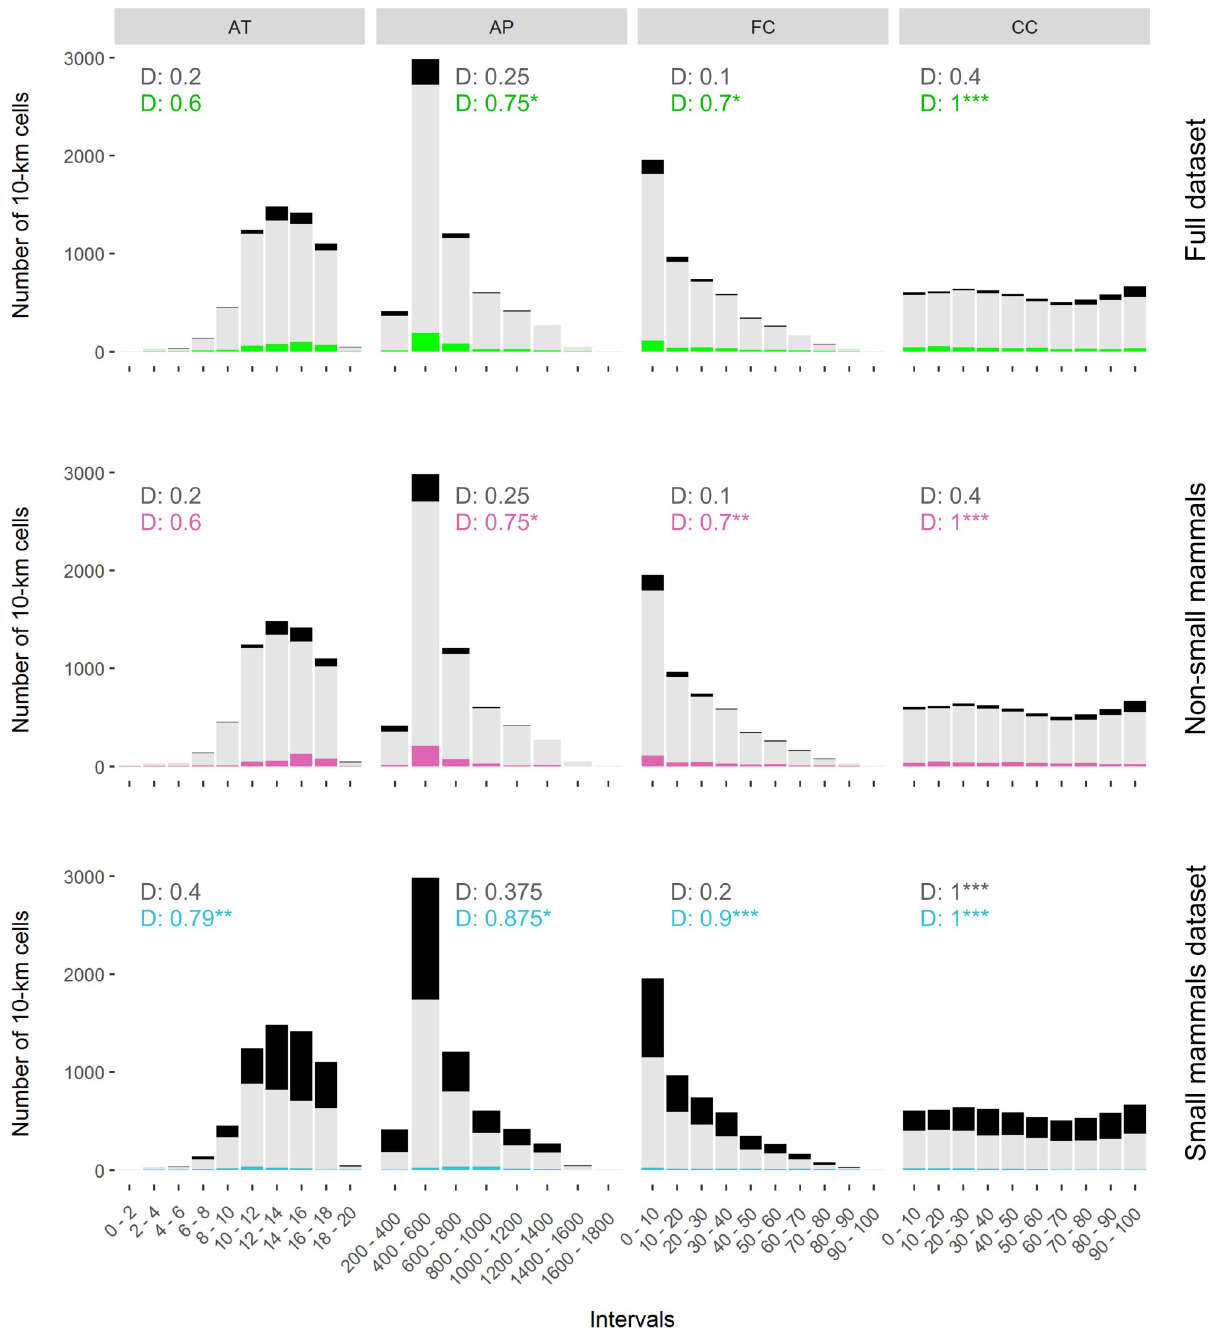
Fig 3. Survey coverage of well-sampled cells (number of records � 25 and Cc � 0.7) along four environmental variables: Annual Mean Temperature (AT), Annual Precipitation (AP), forest coverage (FC), and crops coverage (CC). Green: full dataset; pink: non-small mammals’ dataset (Lagomorpha, Artiodactyla, Carnivora, Chiroptera and Erinaceidae); blue: small mammals’ (Rodentia and Soricidae) dataset; grey: all cells having data (n = 5,874); black: rest of cells in the territory not holding data. Values correspond to the D-statistics from Kolmogorov-Smirnov goodness- of-fit tests. Lever of significance of 0.05 ( � ), 0.01 ( �� ) and 0.001 ( ��� ).